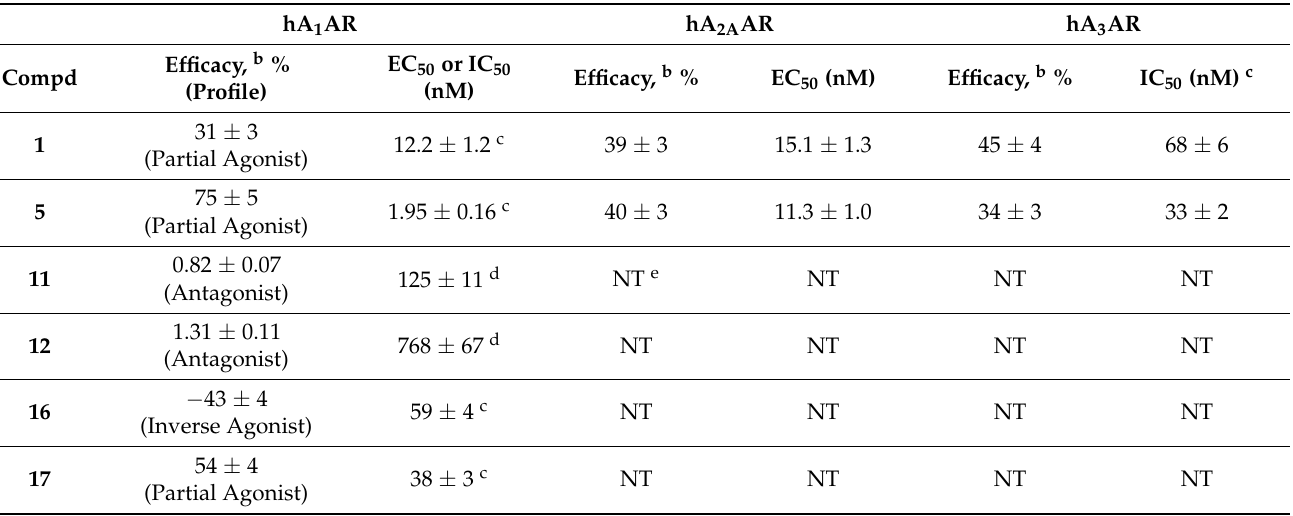
Table 2. Modulation of Forskolin-stimulated cAMP levels of selected amino-3,5-dicyanopyridine derivatives on cyclic cAMP assay in hA 1 , hA 2A and hA 3 CHO cells a